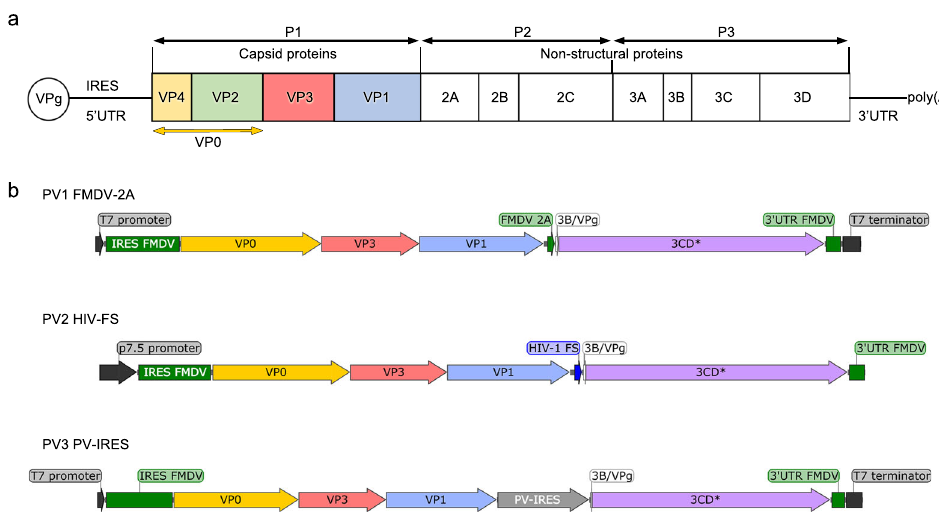
Fig. 1 The poliovirus genome and expression cassettes designed to test P1 and 3CD* co-expression. a Schematic representation of the poliovirus genome highlighting the P1 region and individual capsid protein subunits generated from proteolytic processing by 3CD. b Format of the three separate expression cassettes used to test co-expression of P1 and 3CD* in PV1 wt (FMDV-2A), PV2 wt (HIV-FS) and PV3 wt (PV- IRES). Image was created using SnapGene ® software (from GSL Biotech; available at